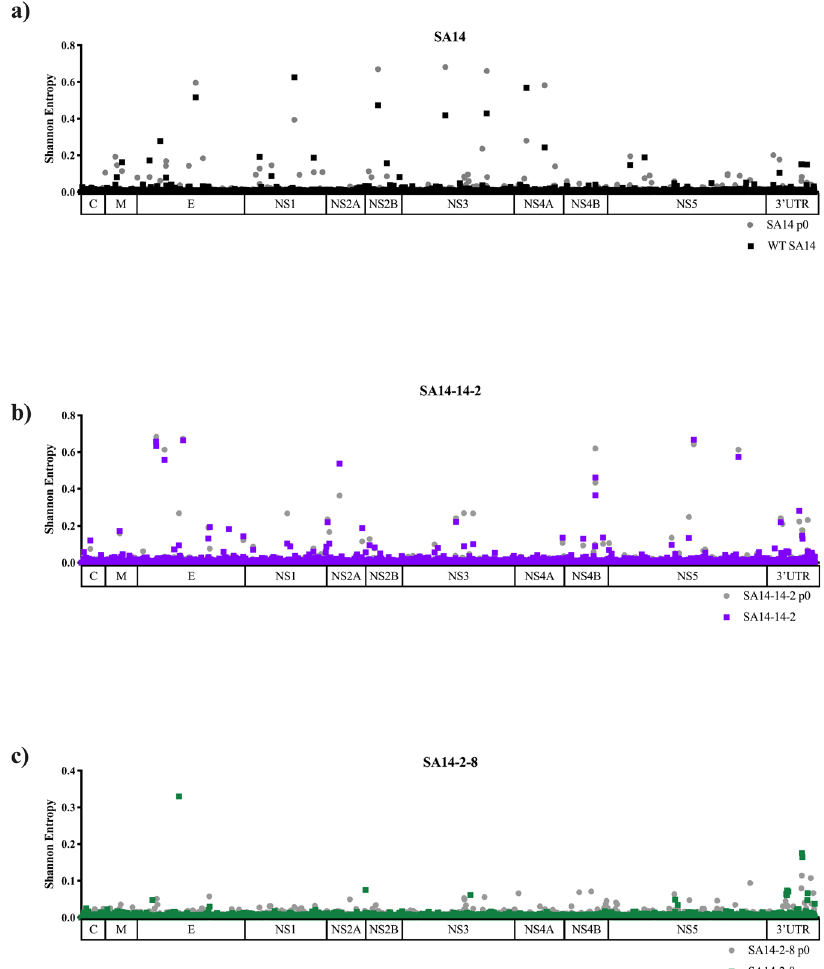
Fig. 3 Genetic diversity of JEV WT and vaccine strains upon passage. The genetic diversity of two sequential passages of SA14 and the three vaccine strains derived from it was compared through Illumina sequencing methods and quanti fi ed using Shannon entropy. The Shannon entropy of SA14 ( a ), SA14-14-2 ( b ), SA14-5-3 ( c ) and SA14-2-8 ( d ) were mapped across the genome. All nucleotide positions, UTRs included, are